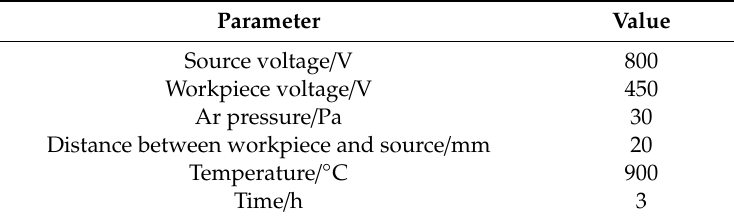
Figure 2. The magnetron sputtering equipment.